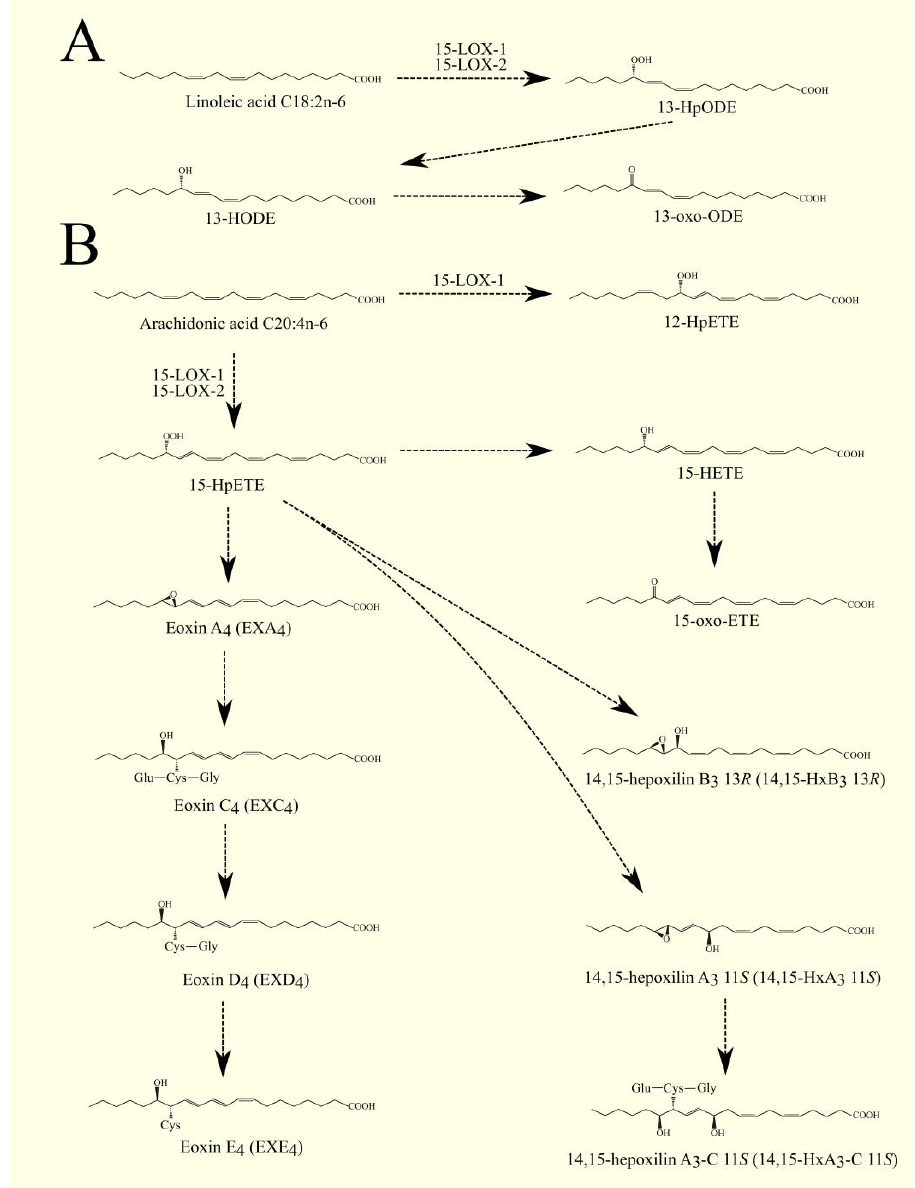
Figure 6. 15-LOX pathway. ( A ). Linoleic acid C18:2n-6 can be converted by 15-LOX-1 and 15-LOX-2 into 13-HpODE. This compound can then be converted into 13-HODE and 13-oxo-ODE. ( B ) 15-LOX-1 and 15-LOX-2 can convert ARA C20:4n-6 into 15-HpETE. 15-LOX-1 can also convert this fatty acid into 12-HpETE. 15-HpETE can then be converted into EXA 4 and into cysteinyl-eoxins EXC 4 , EXD 4 , and EXE 4 . 15-HpETE can also be converted into hepoxilins 14,15-HxA 3 11 S , and 14,15-HxB 3 13 R . 14,15-HxA 3 11 S can be converted to cysteinyl hepoxilins, such as 14,15-HxA 3 -C 11 S